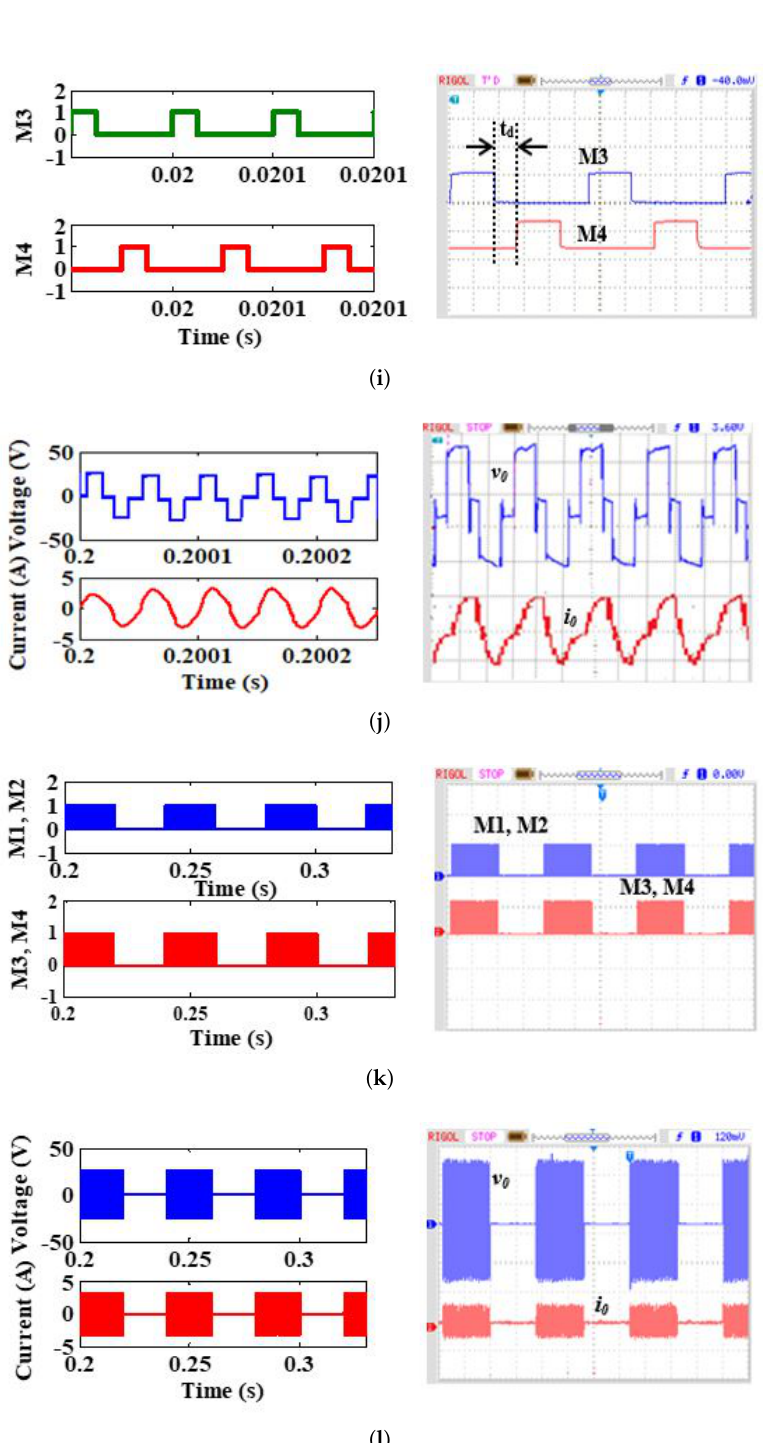
Figure 21. Various modulated simulation and experimental waveforms: square pulse